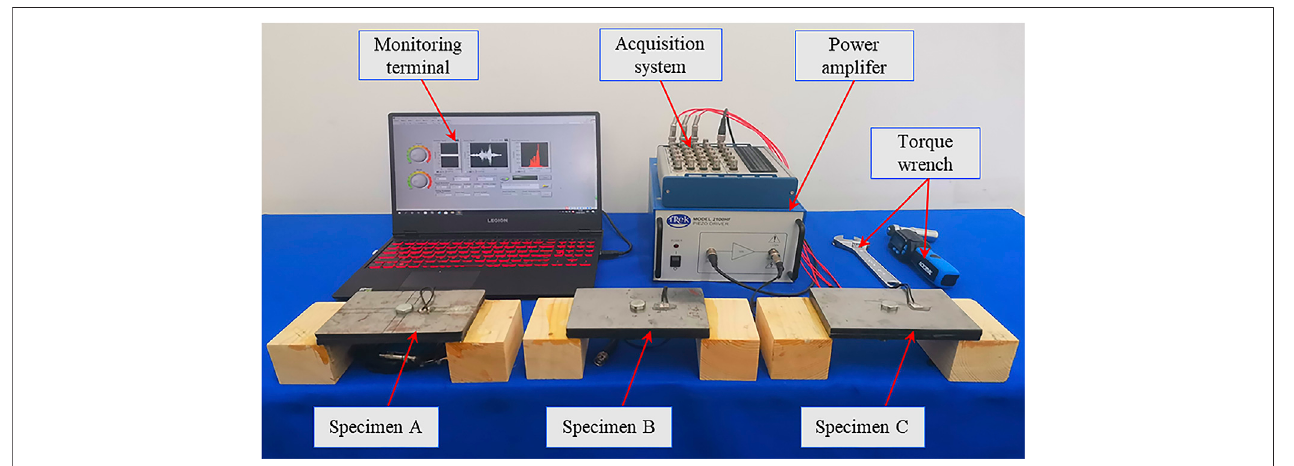
FIGURE 9 | Experimental setup of monitoring the bolt looseness using the piezoelectric active sensing method.